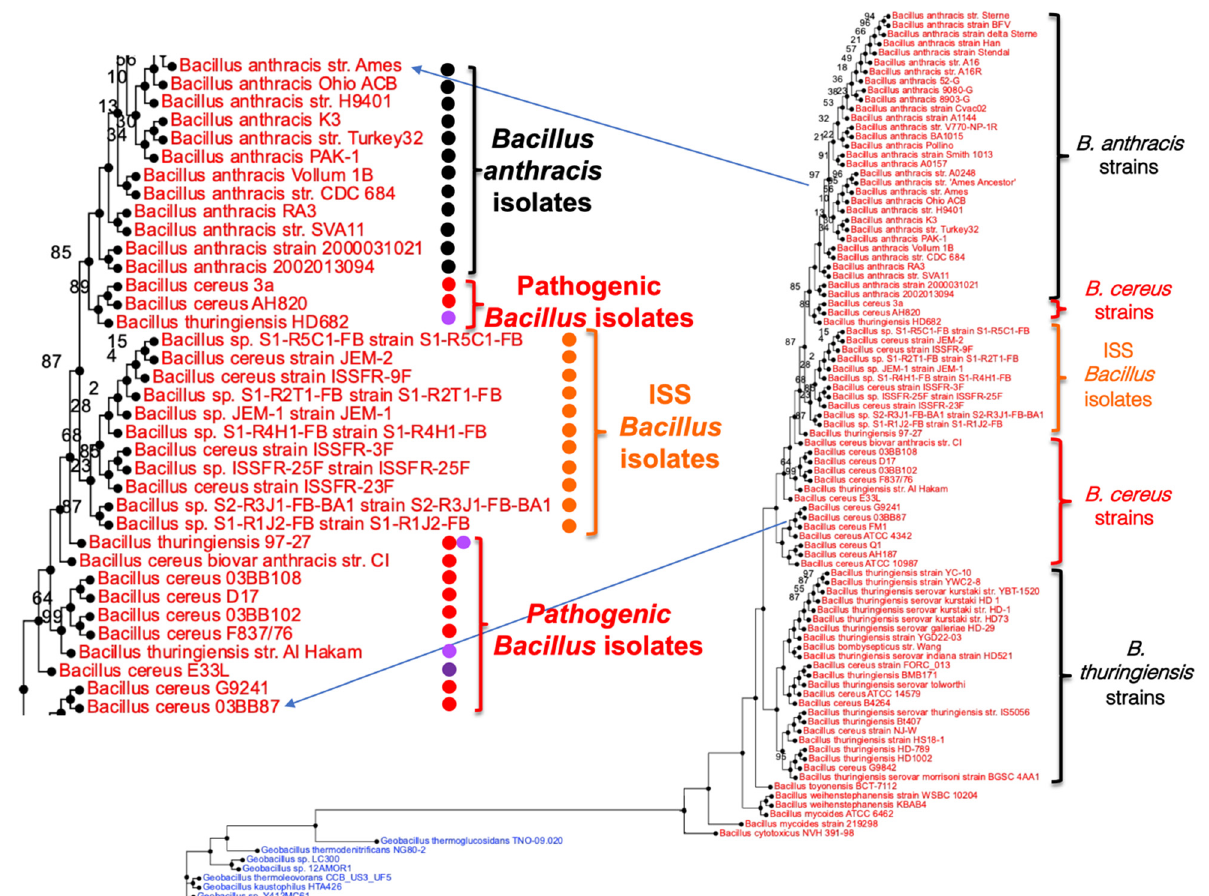
Figure 2. The ISS Bacillus isolates are close related to B. anthracis and B. cereus pathogenic strains. Maximum-likelihood phylogenetic tree was constructed using complete genome sequences of 96 Bacillus isolates (listed in SI) using the PathoSystems Resource Integration Center (PATRIC) (see M&M). Bacillus isolates obtained from the ISS between 2005 and 2011 are indicated by orange dots and orange font. Terrestrial Bacillus isolates known to be pathogenic to humans and/or other primates (causing anthrax like disease) are indicated by red dots and red font. Terrestrial Bacillus isolate pathogenic to other animals is indicated by purple dot. Those isolated obtained from other courses (e.g., soil) are indicated by black dots and black font. Terrestrial B. thuringiensis strains lacking genes coding for the parasporal crystal are indicated by pale purple dots (for references, see Supplementary File 1).